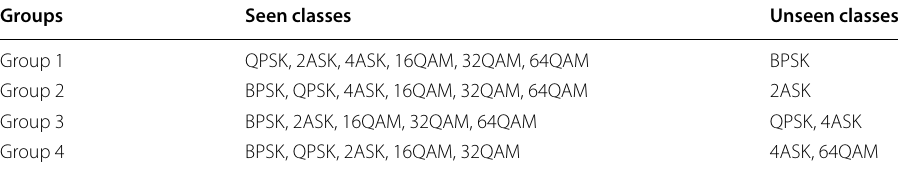
Table 4 The semantic description of each category Groups Seen classes